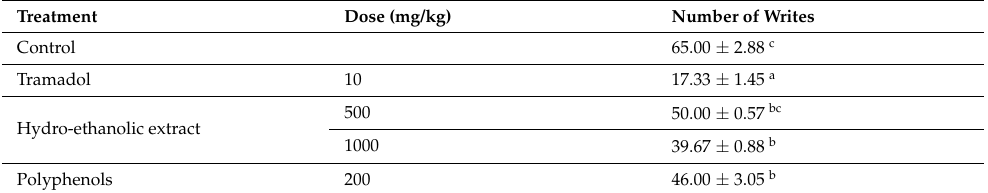
Table 6. Effect of P. sativum Hoffm. on acetic acid-induced writhing in mice ( n = 5).